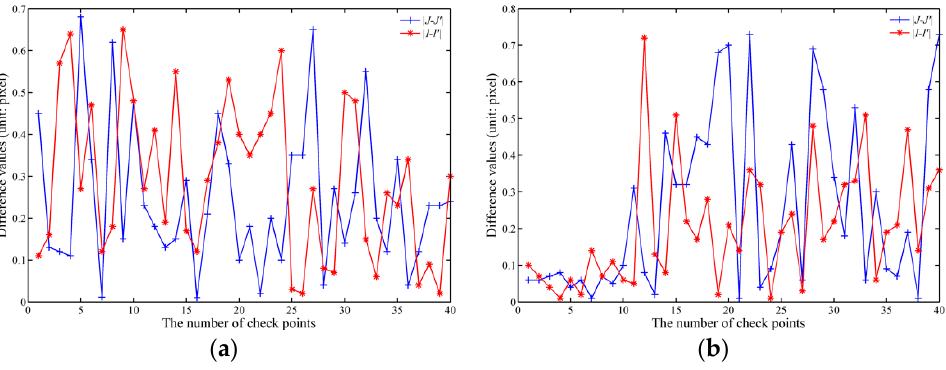
Figure 18. Different statistical analyses for the FPGA-based method and Matlab-based method for: ( a ) the first study area; and ( b ) the second study area.